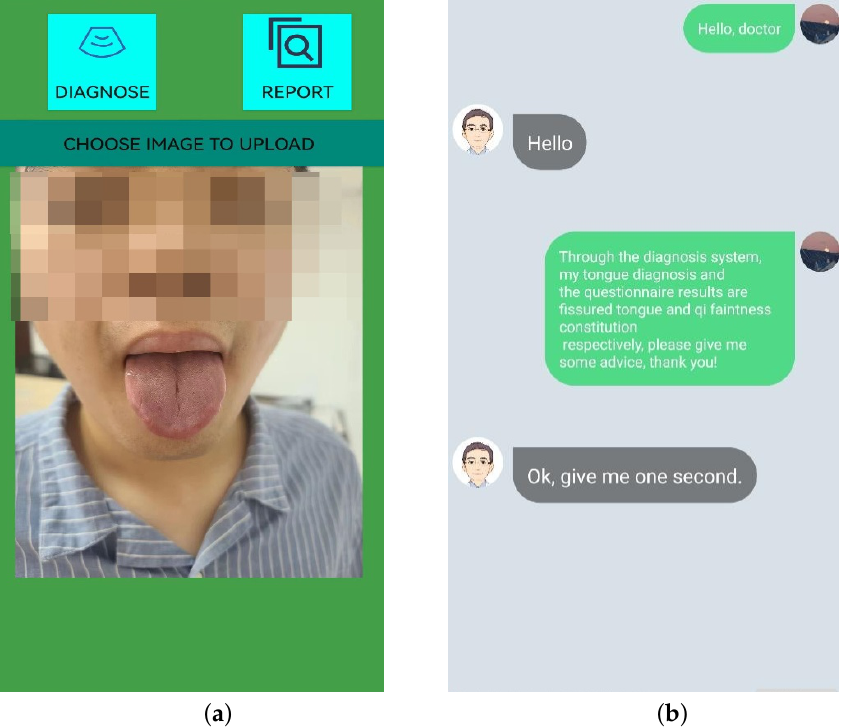
Figure 2. Interfaces of the tongue system. ( a ) The interface to upload tongue images. ( b ) The dialog window.